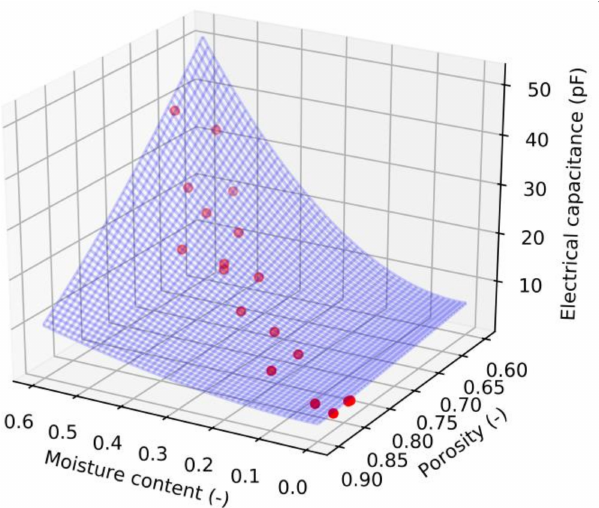
Figure 9. Plotted measured capacitance data (red points) for forest wood chips at1 MHz frequency and mathematical model based on the Equation (5)—blue surface.